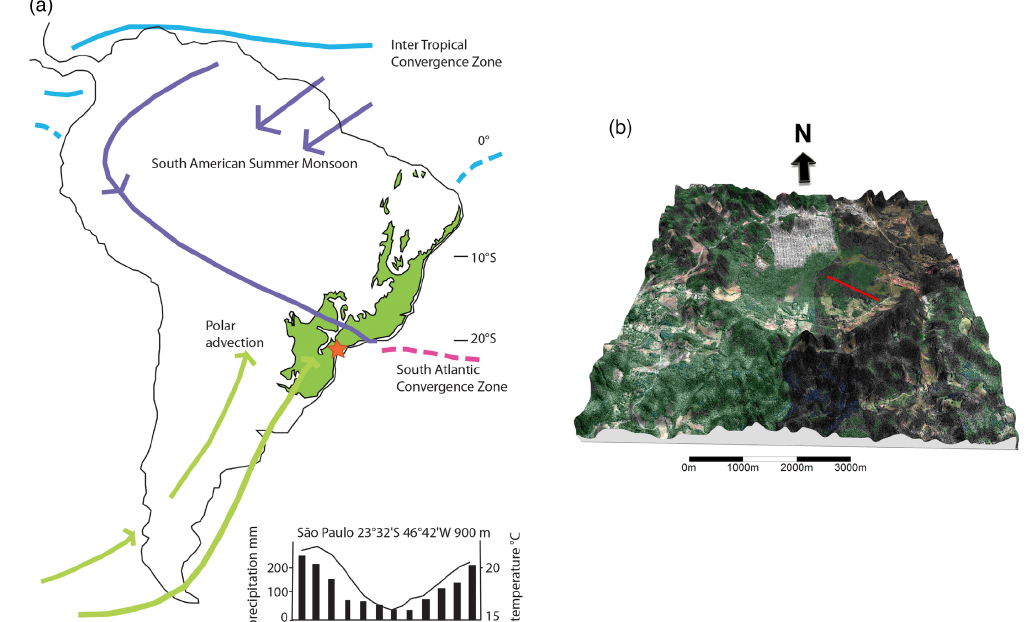
Figure 1. (a) Map of South America. The green area illustrates the present extent of the Atlantic rainforest and the red star indicates the location of Colônia. The site is located in a key position between the austral summer (north of Colônia) and winter (south of Colônia) rainfall pattern and atmospheric circulation. The northern circulation is dominant today with the activity of the South American summer monsoon (purple) and Intertropical Convergence Zone (ITCZ) seasonal shifts (light blue plain and dotted lines showing austral winter and summer positions, respectively). (b) 3-D view of the Colônia structure combining an Ikonos satellite image and a digital elevation model with a 6.5 x vertical exaggeration. The red line indicates the present extent of the